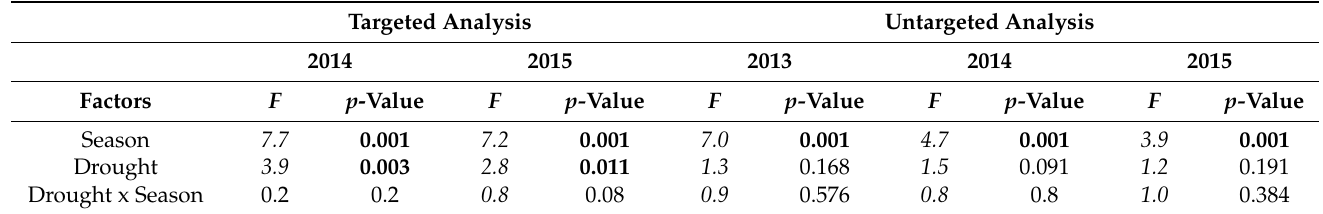
Figure 1. Principal component analysis (PCA) on phenolic compounds (targeted analyses) according to years and seasons in 2014 ( left ) and 2015 ( right ). Table 1. Two-way PERMANOVA (999 permutations) performed on targeted and untargeted data to distinguish the effects of factors (season and drought) and their interactions (n = 5). F represents the dispersion of the data set and the significant p -value are indicated in